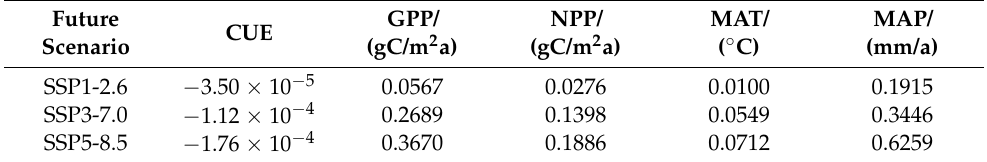
Table A1. Comparison of CUE, GPP, NPP, MAT and MAP tendency rates in three scenarios.